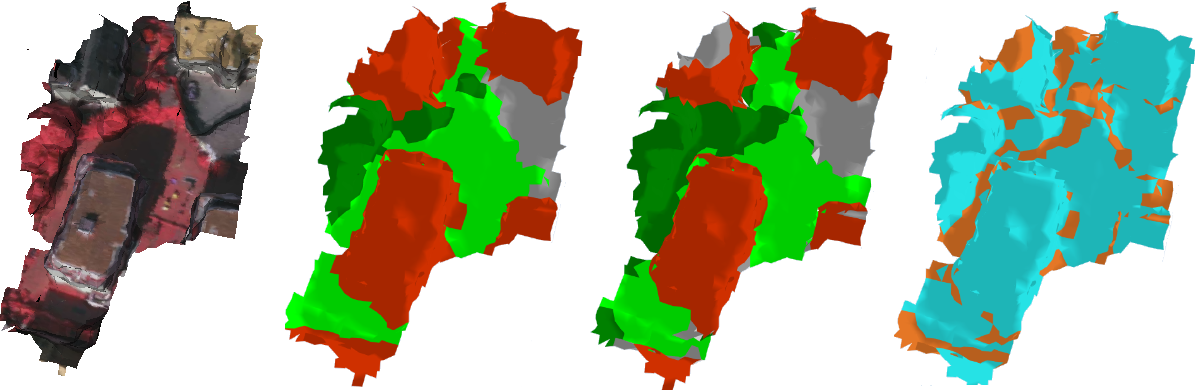
Figure 5. A test set sample classified by MeshCNN with photometric and geometric features: (left) The textured mesh; (mid-left) ground truth; (mid-right) prediction, where dark green, light green, gray, and red colors encode high vegetation, low vegetation, ground, and buildings respectively; (right) difference plots between ground truth and prediction, where orange are wrongly predicted